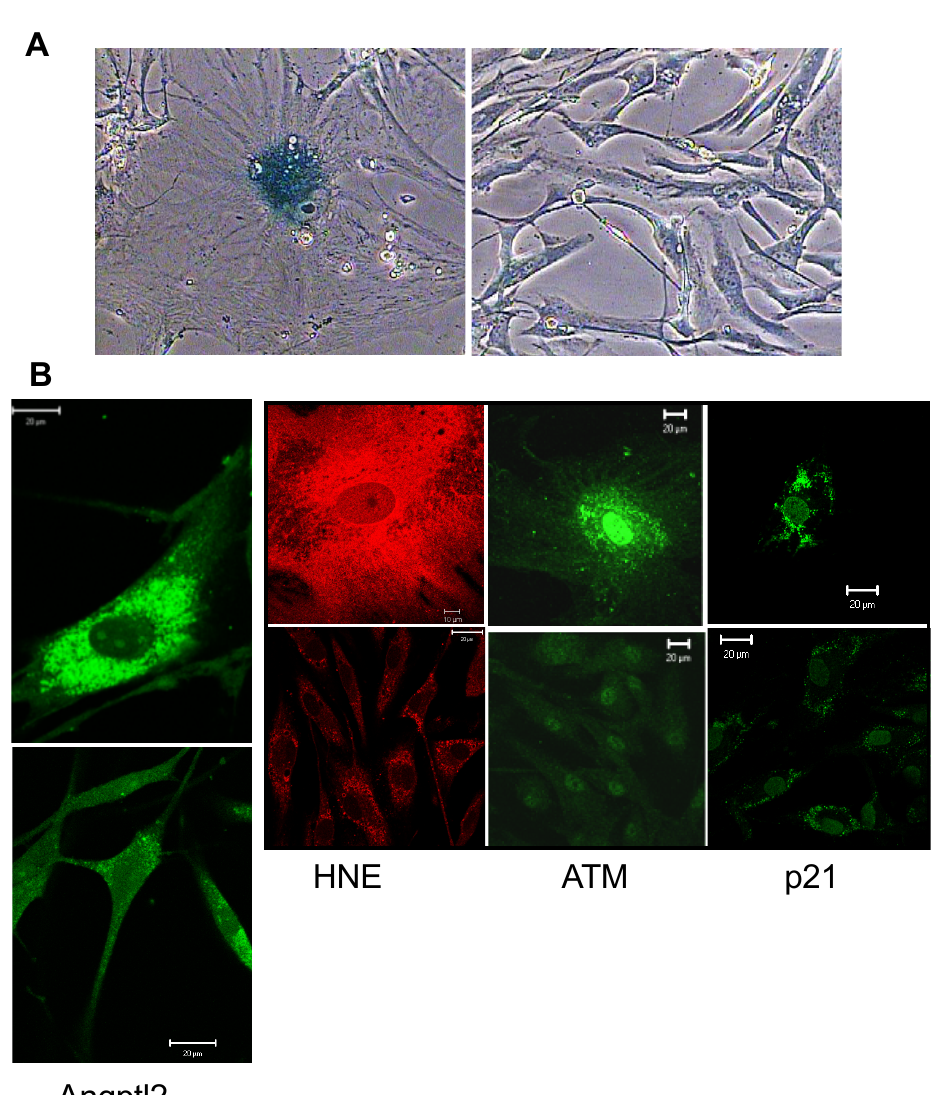
Figure 1. Angptl2 expression in human senescent endothelial cells. ( A ) Senescence-associated β -galactosidase staining of senescent (left panel) compared to non-senescent (right panel) cultured hIMAEC; same magnification × 400 (adapted from [61]). ( B ) Immunofluorescence images of senescent (top panel) compared to non-senescent (bottom panel) cultured hIMAEC for angptl2 (adapted from [53]), the oxidative stress marker HNE (adapted from [61]), the DNA damage marker ATM (adapted from [62]) and the senescent marker p21 (NTT, unpublished data). ATM: ataxia-telangiectasia mutated; hIMAEC: human internal mammary artery endothelial cells; HNE: hydroxy-nonenal.